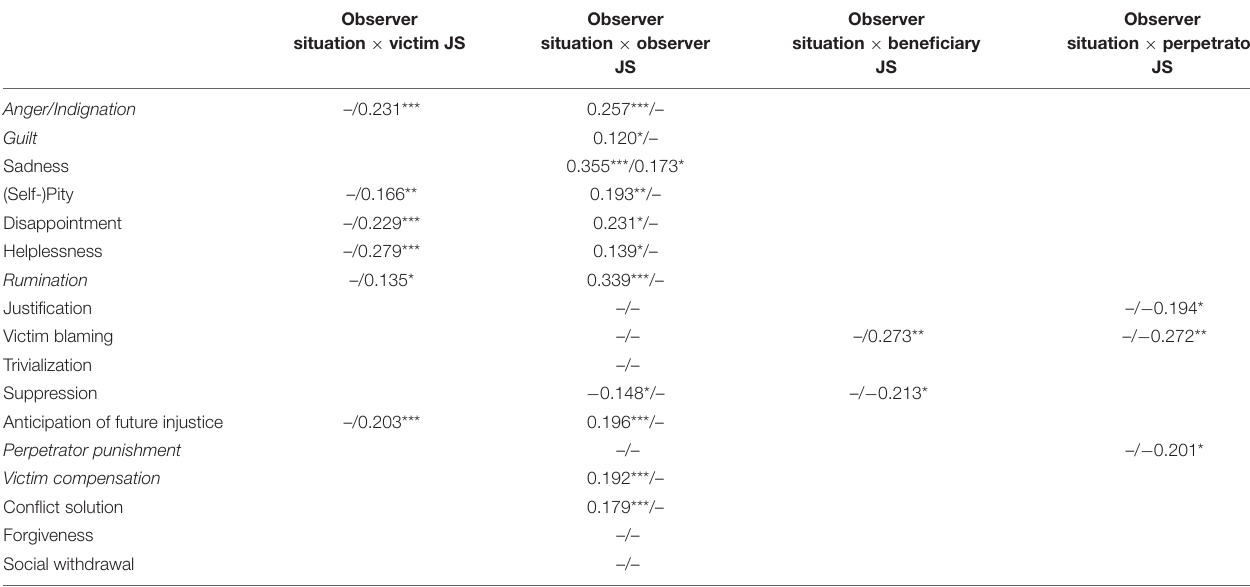
TABLE 6 | Prediction of responses in situations from the observer’s perspective by the JS facets when including only observer JS/all